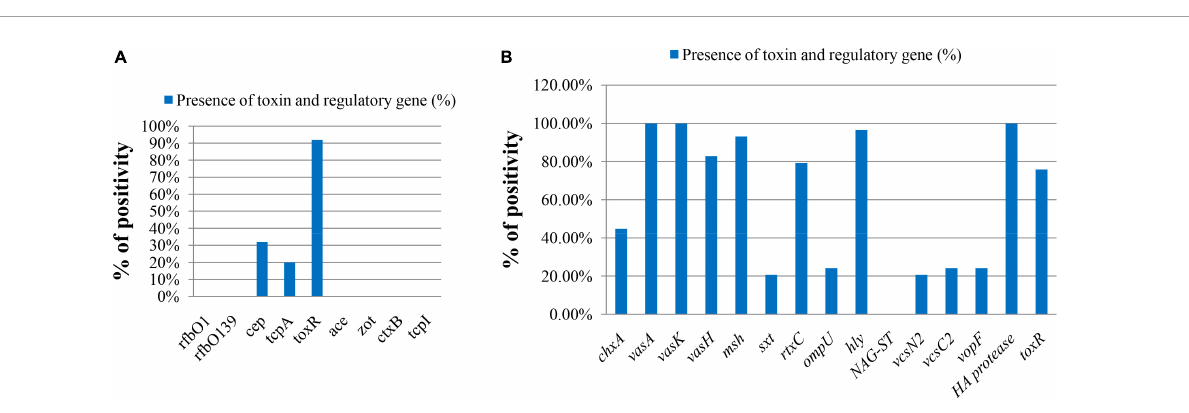
FIGURE3 The molecular pattern of ompW -positive sample on the basis of toxin and regulatory genes of V. cholerae. (A) Direct DNA sample (% bar chart); (B) DNA sample of confirmed isolated V. cholerae strains (% bar